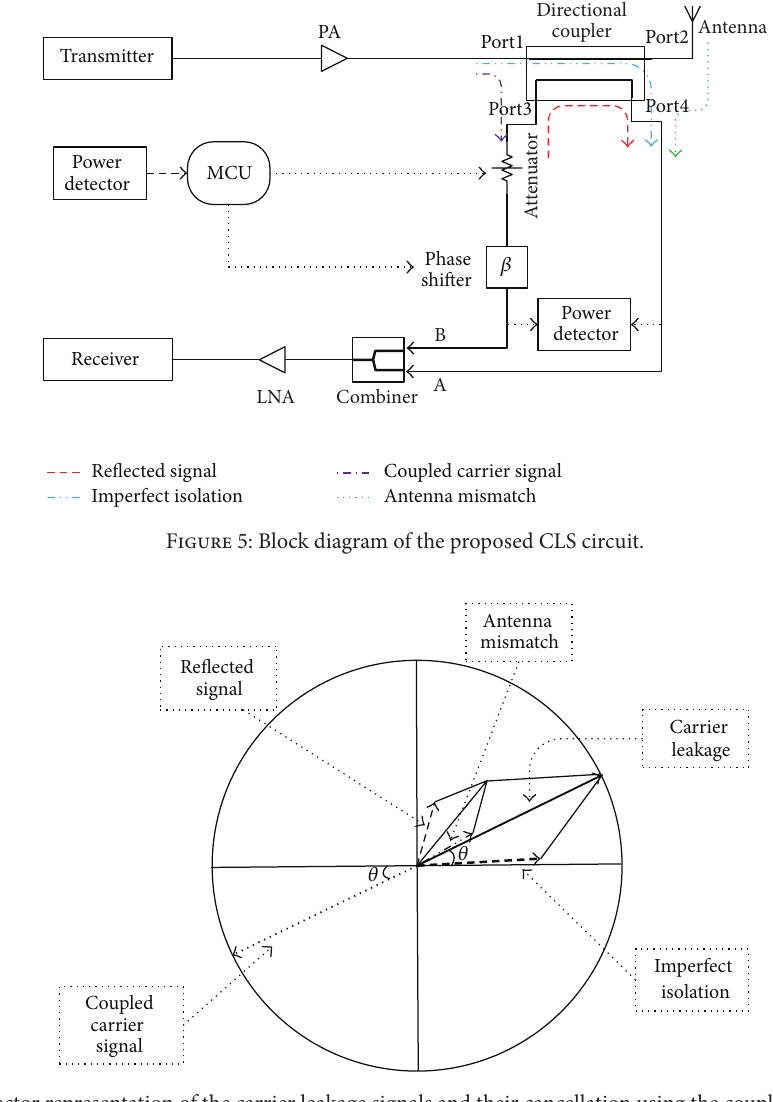
Figure 6: Vector representation of the carrier leakage signals and their cancellation using the coupled carrier